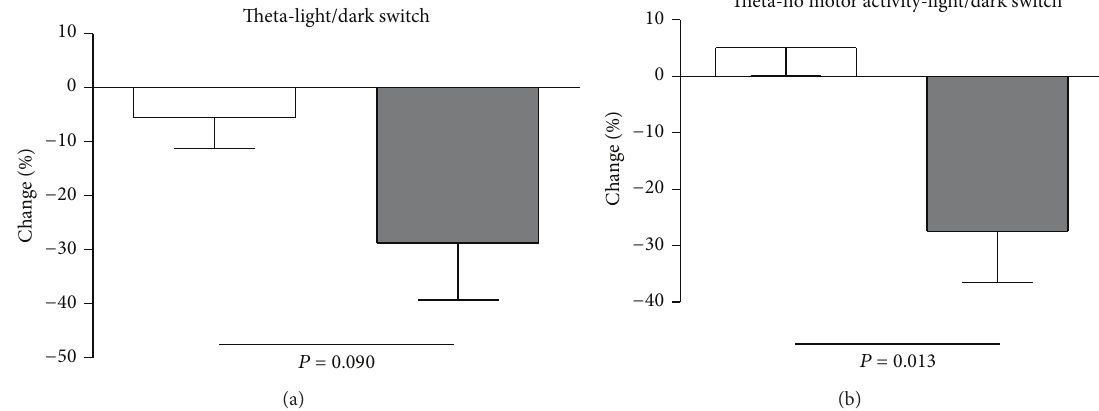
Figure 7: Percentage change in theta duration during light/dark switch. Data from Figures 6(b), 6(c), 6(e), and 6(f) were used to calculate the percentage change in theta duration for every individual mouse during the total observation period (48 h, (a)), during nonmotor activity (b) and motor activity (not shown). During switch from light to dark cycle a statistic trend for theta duration increase turned out to exist in 5XFAD mice (a). Again, this effect was most prominent and significant during no motor activity (b) and absent during motor